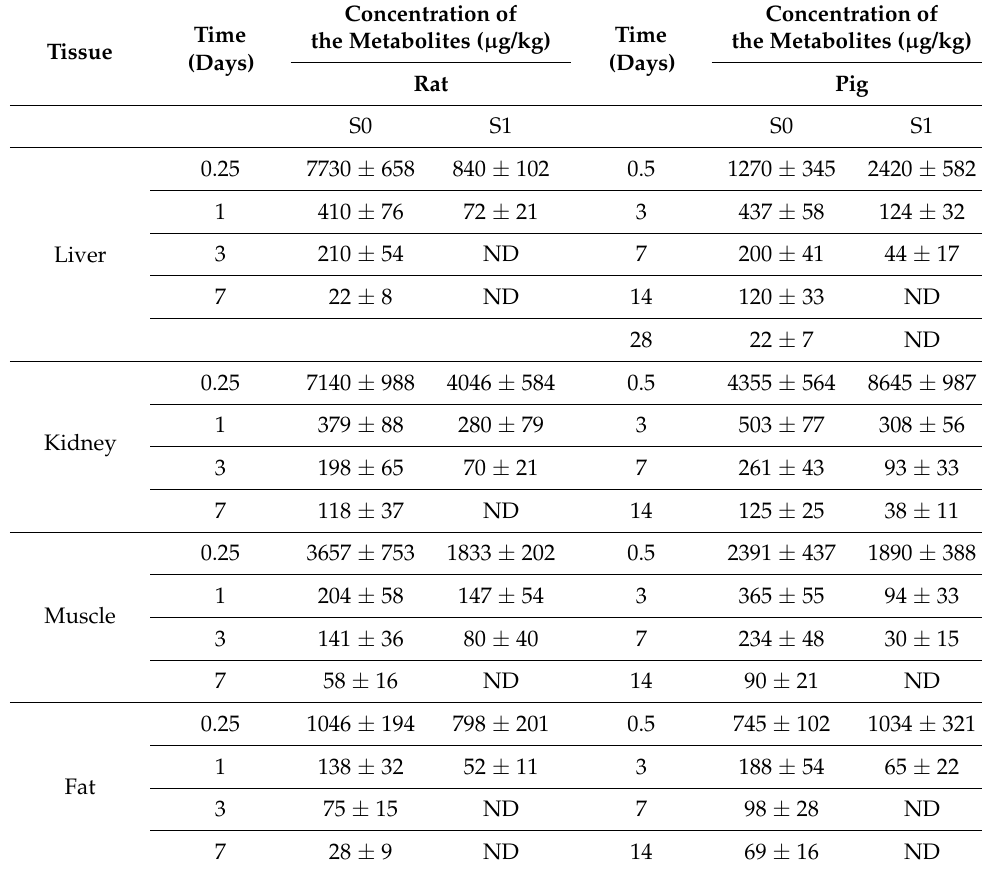
Table 4. Concentration of SMZ and its metabolites in tissues of rat and